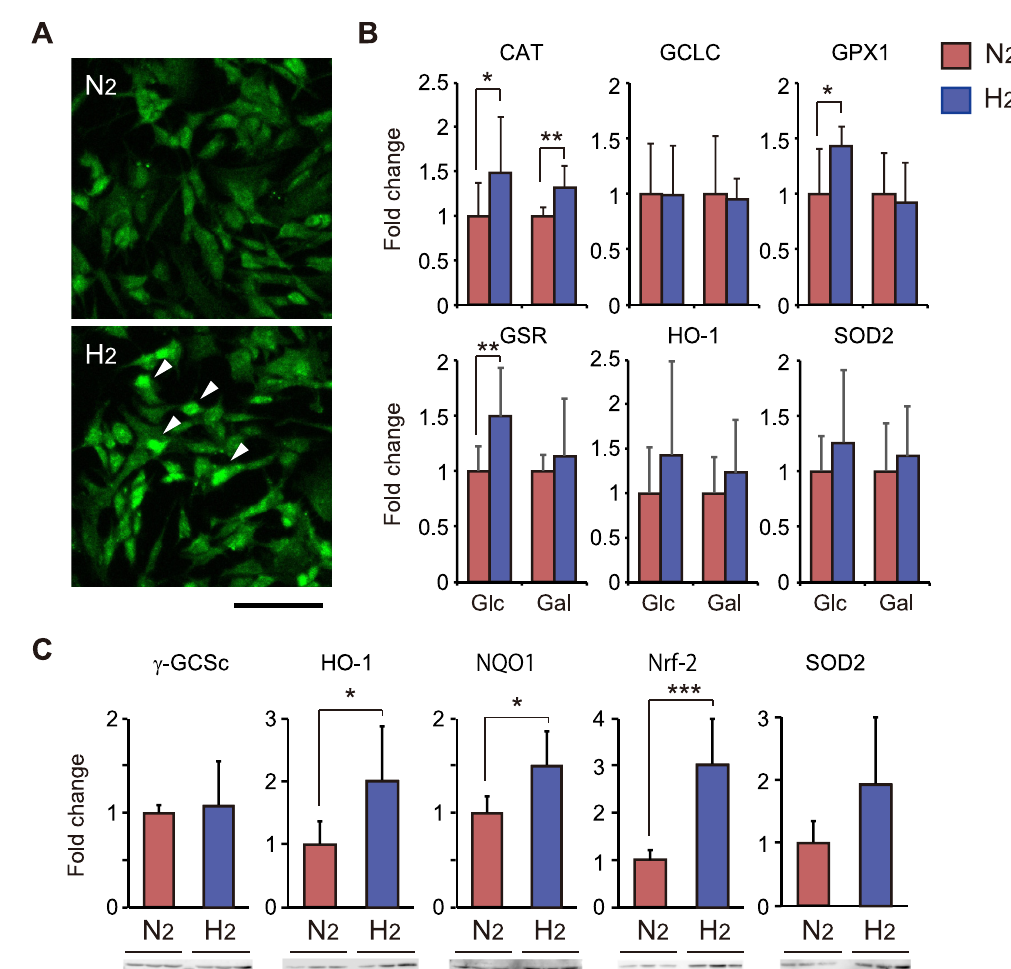
Fig 5. The H 2 -induced anti-oxidative defense system. (A) SH-SY5Y cells were stained with an anti-Nrf2 antibody.H 2 treatment inducedtranslocation of Nrf2 into the nucleus(arrow heads). The scale bar is 100 μ m. (B) Cells were incubatedin culture medium containing either Glc or Gal under N 2 - or H 2 -mixed gas for 18 h. The transcript levels of genes involvedin the anti-oxidative defensesystem, including CAT, GCLC, GPX1, GSR, HO-1 and SOD2, were quantifiedby real-time PCR analysiscoupledwith reverse transcription of total RNA, and expressedrelative to those in cells incubatedunder N 2 -mixed gas. (C) The expressionlevels of proteins involvedin the anti-oxidative defensesystem, including γ -GCSc, HO-1, NQO1, Nrf2 and SOD2, were quantified by the intensity of representative immunoblots (n = 5 or 6, each), and expressedrelative to those in cells incubatedunder N 2 -mixed gas. * P < 0.05, ** P < 0.01. *** P <